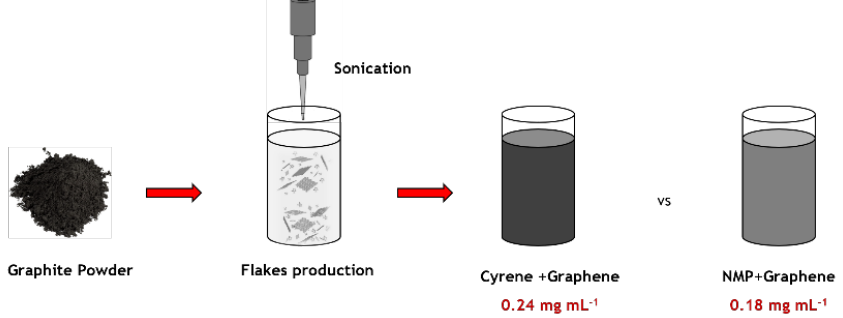
Figure 4. Liquid-phase exfoliation method providing higher